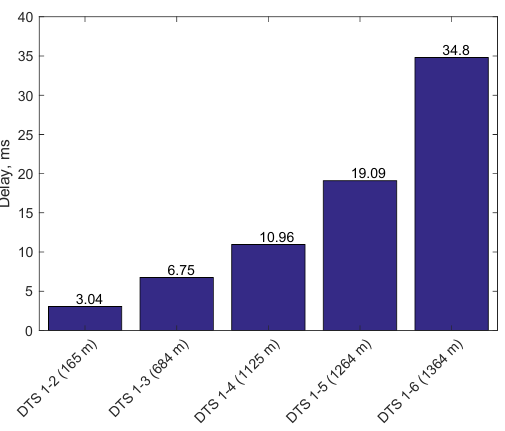
Figure 10. Impact of repeaters on round-trip time calculated during connection establishment.